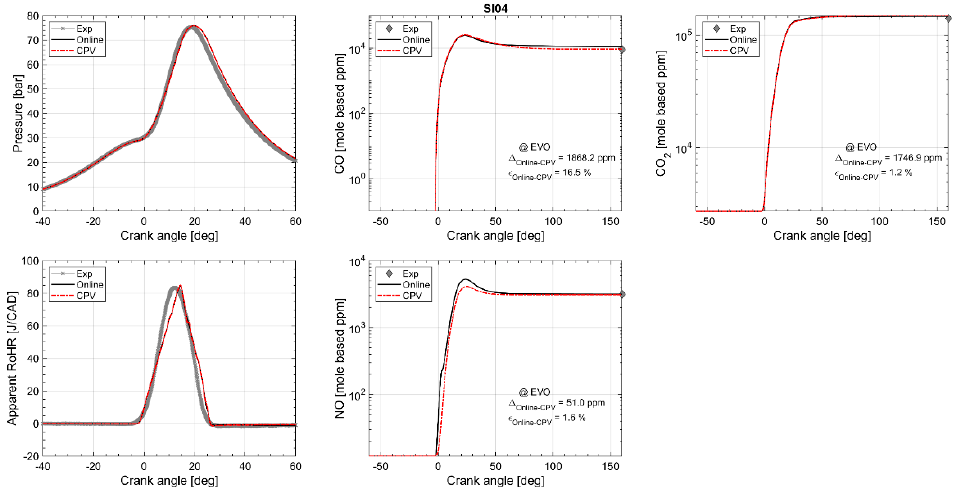
Figure A14. Engine performance and emissions for operating point SI04 (2000 rpm, 15.0 bar IMEP).